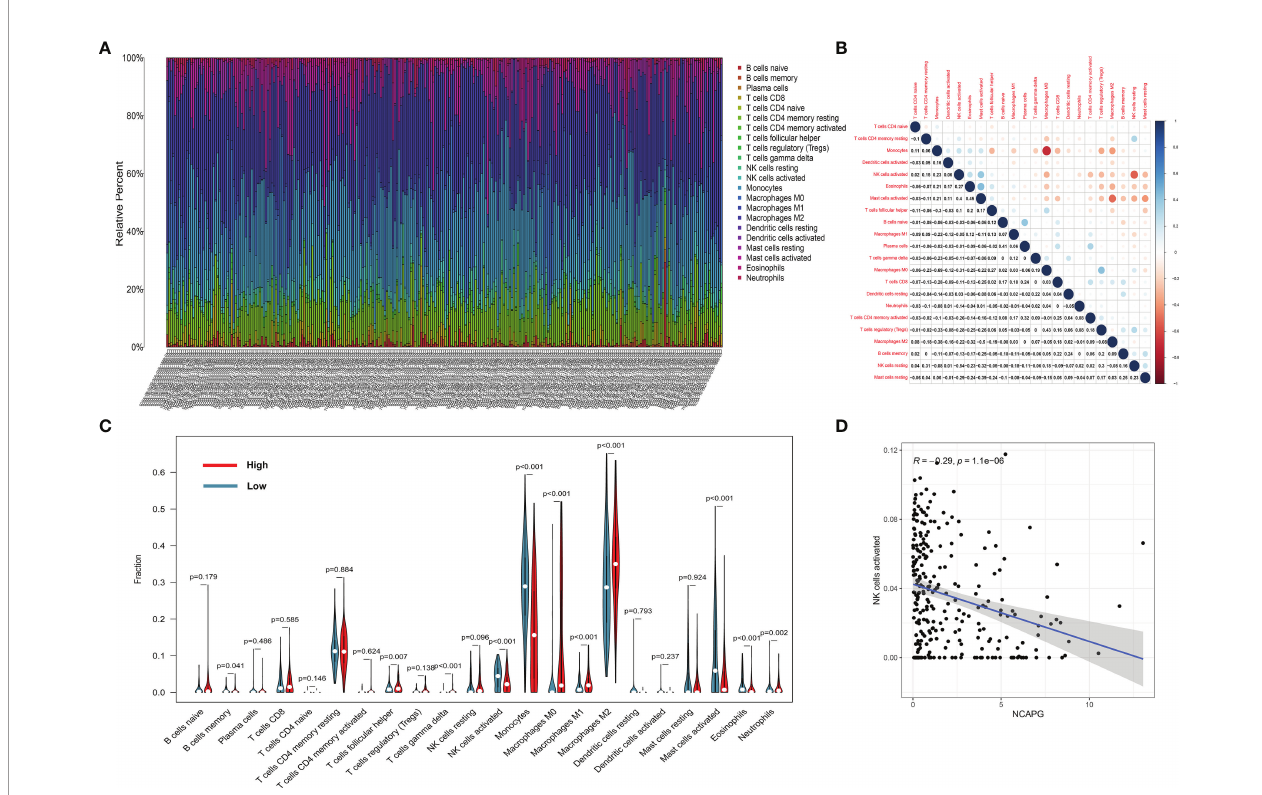
FIGURE 6 | The landscape of immune in fi ltration in glioma cells. (A) The proportions of immune cells in each glioma sample are indicated with different colors, and the lengths of the bars in the bar chart indicate the levels of the immune cell populations. (B) Correlation matrix for all 22 immune cell proportions. Some immune cells were negatively related, represented in blue, while others were positively related, represented in red. The darker the color, the higher the correlation ( P < 0.05). (C) Violin plot visualizing the differentially in fi ltrated immune cells. (D) the relation between the expression of NCAPG and NK cell